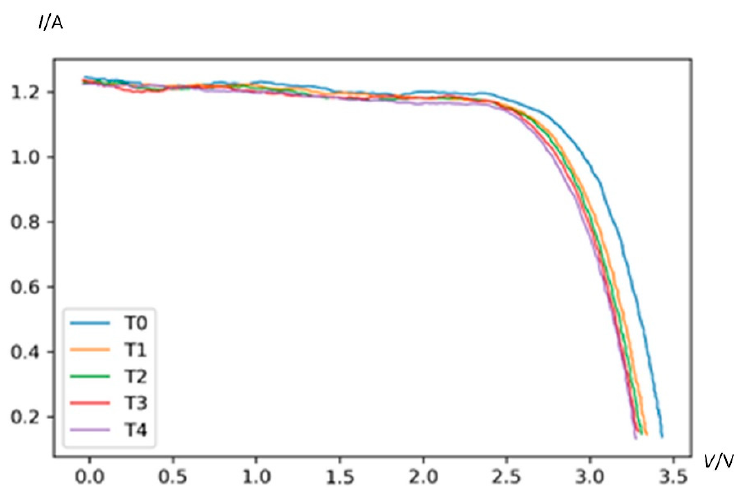
Figure 25. I-V curves of a mini-PV module of six cells at different temperatures. T 0 < T 1 < T 2 < T 3 < T 4 .